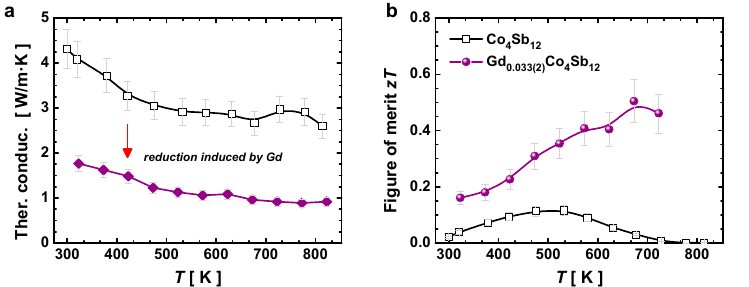
Figure 8. ( a ) Total thermal conductivity and ( b ) thermoelectric figure of merit ( zT ) of the unfilled and the Gd-filled compound obtained under high pressure at 3.5 GPa.